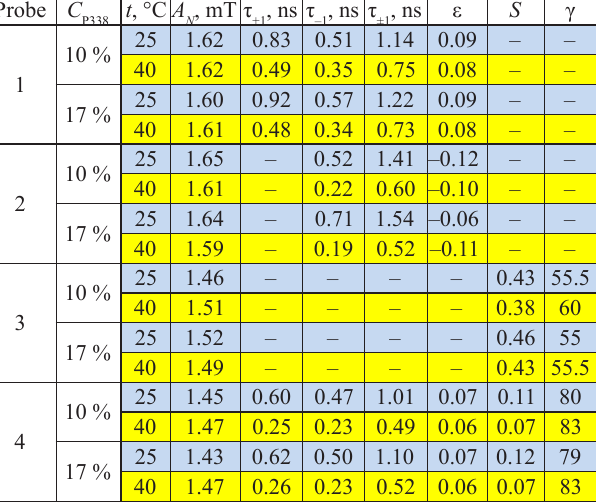
Fig. 18. EPR spectra of the spin probes 1–4 in 17 % aqueous solution of P338 Parameters of EPR spectra of spin probes 1, 2, 3 and 4 in P338 aqueous solutions at 25 °С and 40